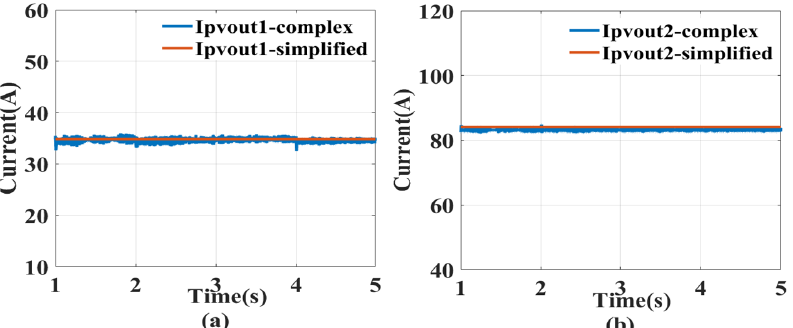
Figure 5. The output current comparison of PV system: ( a ) the comparison for PV system 1 and ( b ) the comparison for PV system